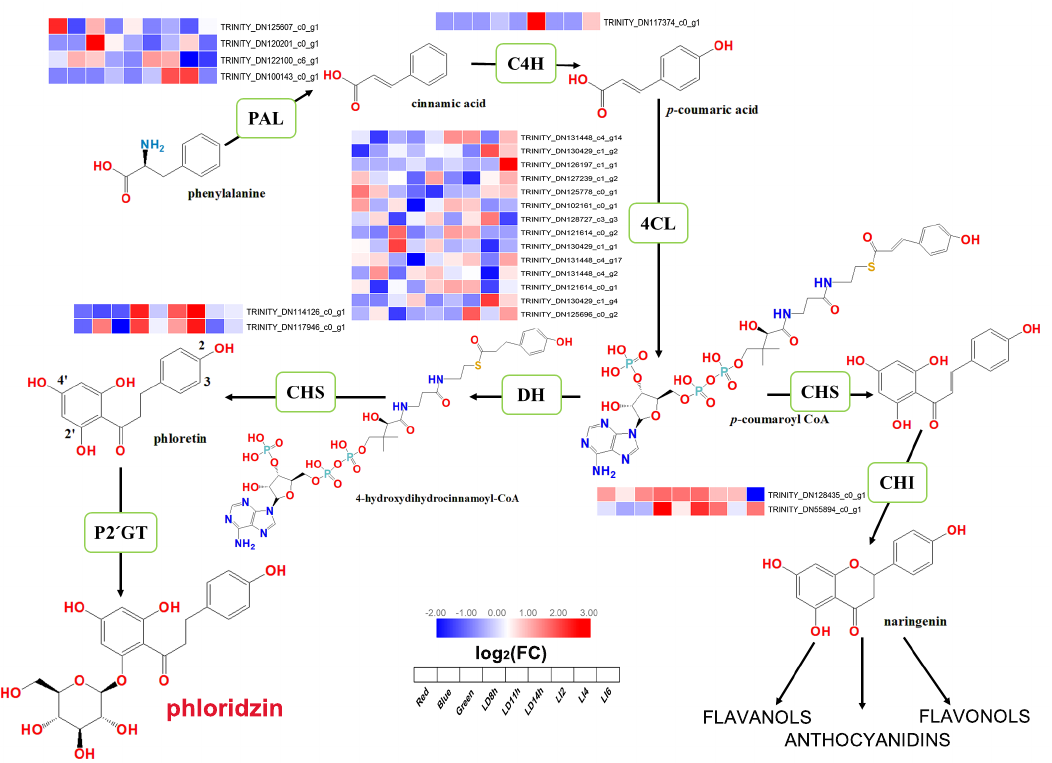
Figure 7. Di ff erentially expressed genes in the phlorizin accumulation pathway. The di ff erent colors in the heat map show unequal expression levels, and red and blue in the formula represent oxygen and nitrogen atoms,